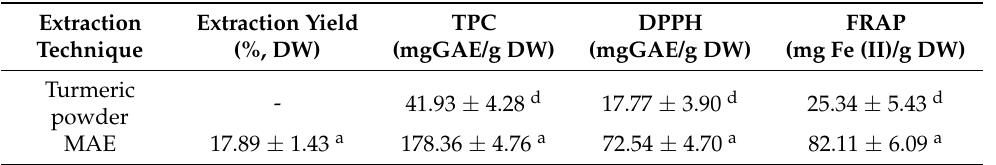
Table 1. Extraction yield, total phenolic content and antioxidant properties: total phenolic con- tent, DPPH and FRAP of turmeric powder and turmeric powder obtained by different extraction techniques 1